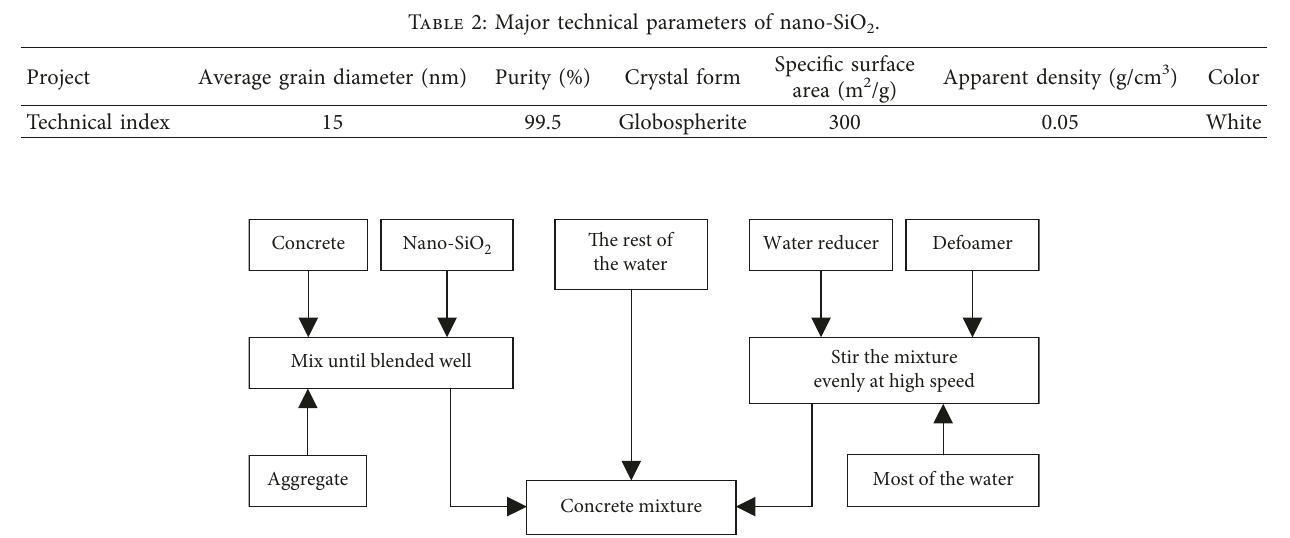
Table 2: Major technical parameters of nano-SiO